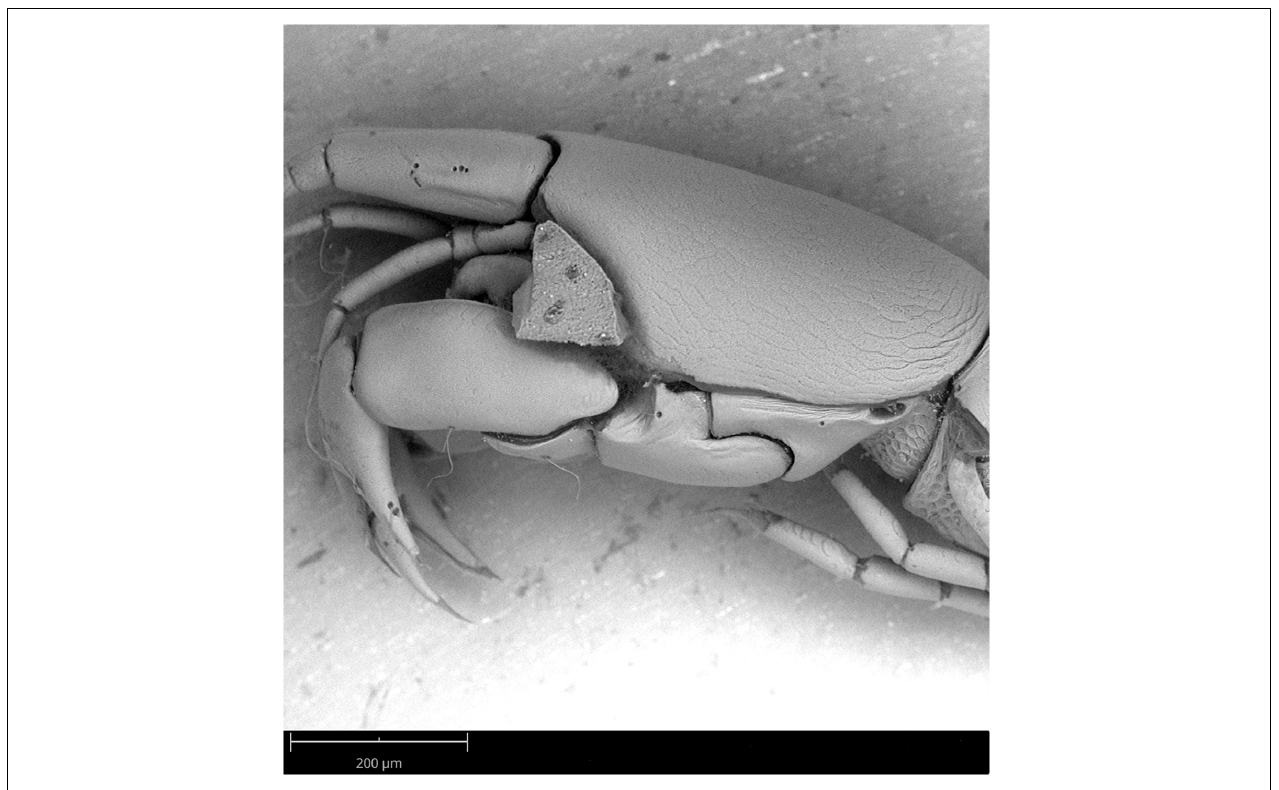
FIGURE 1 | Hamatipeda mojito n. sp.: cheliped/cephalothorax details showing sclerite enfolding the posterior lobe of the cheliped basis.